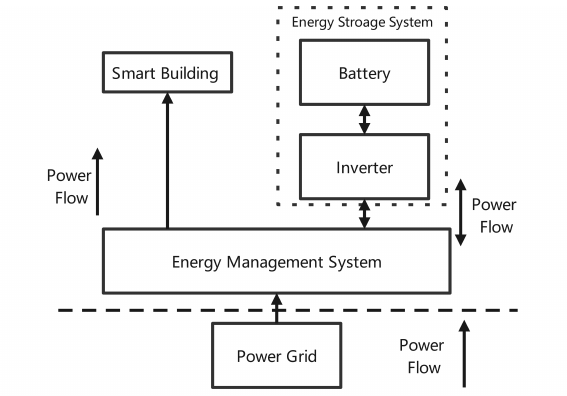
Figure 1. EMS of a smart